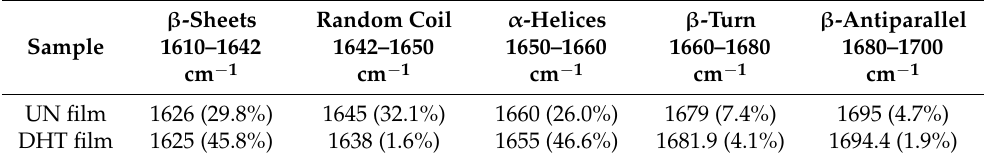
Figure 2. Gaussian deconvolution of UN ( left ) and DHT ( right ) collagen film amide I (1600–1700 cm − 1 ) into four component bands, that were β -sheet (blue line, 1610–1642 cm − 1 ), random coil (purple line, 1642–1650 cm − 1 ), α -helix (orange line, 1650–1660 cm − 1 ), β -turn (pink line, 1660–1680 cm − 1 ), and β -antiparallel (teal line, 1680–1700 cm –1 ) components were detected. The fitted curve is reported with a green (UN) or red (DHT) line, closely overlapping the experimental curve (black line). Table 1. Secondary structure peaks and percentage analysis of uncrosslinked and cross-linked collagen matrices in the 1600–1700 cm −1 spectral range.